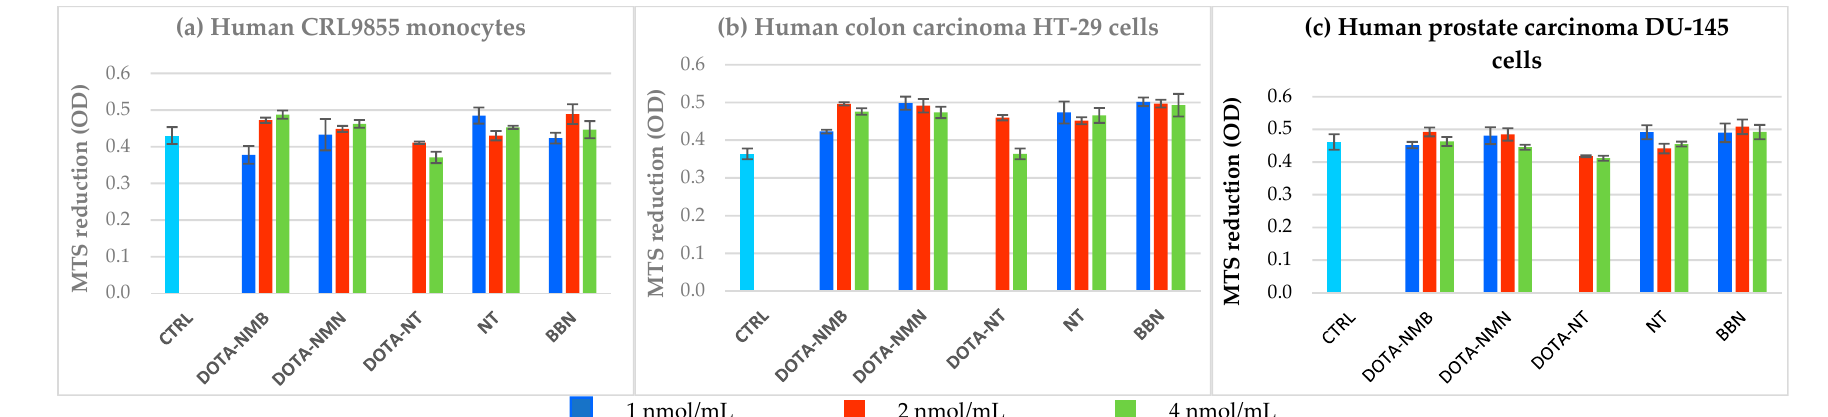
Figure A2. MTS reduction by human CRL955 monocytes ( a ), human colon carcinoma HT-29 cells ( b ) and human prostate DU-145 carcinoma cells ( c ) incubated for 48 h with bare NPs (AuNP) or with peptide-loaded NPs (DOTA-PEG-BBN-AuNP, DOTA-NMB-AuNP, DOTA-NMN-AuNP, DOTA-NT-AuNP). Results are presented as mean ± SEM (standard error of the mean) for triplicate samples.